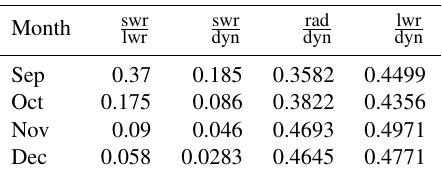
Table 3. The seasonal development (October–December) of the in- d | T | tend1 , and tend1 and tend2 denote two different time tendency d | T | tend2 terms for the wave 1 temperature amplitude, averaged over 80– 40 ◦ N, 50–0.5mb, for the 3DO 3 run. The terms shown are the time tendency terms due to shortwave and longwave radiation, and dy-